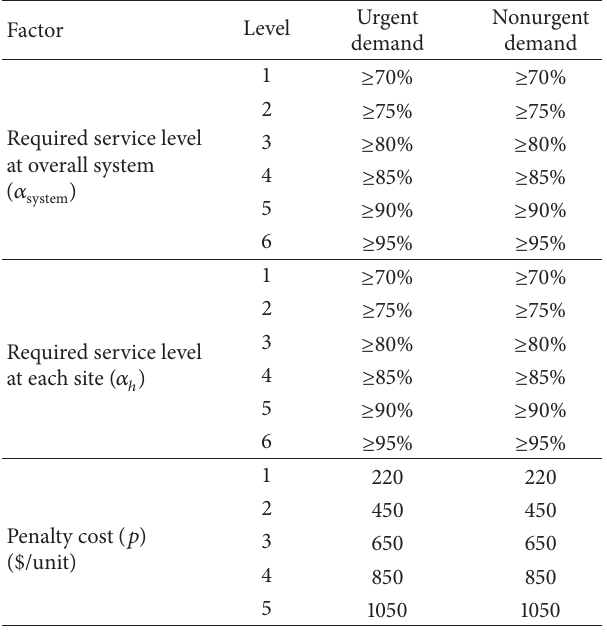
Table 3: Considered factors and their levels for problem set